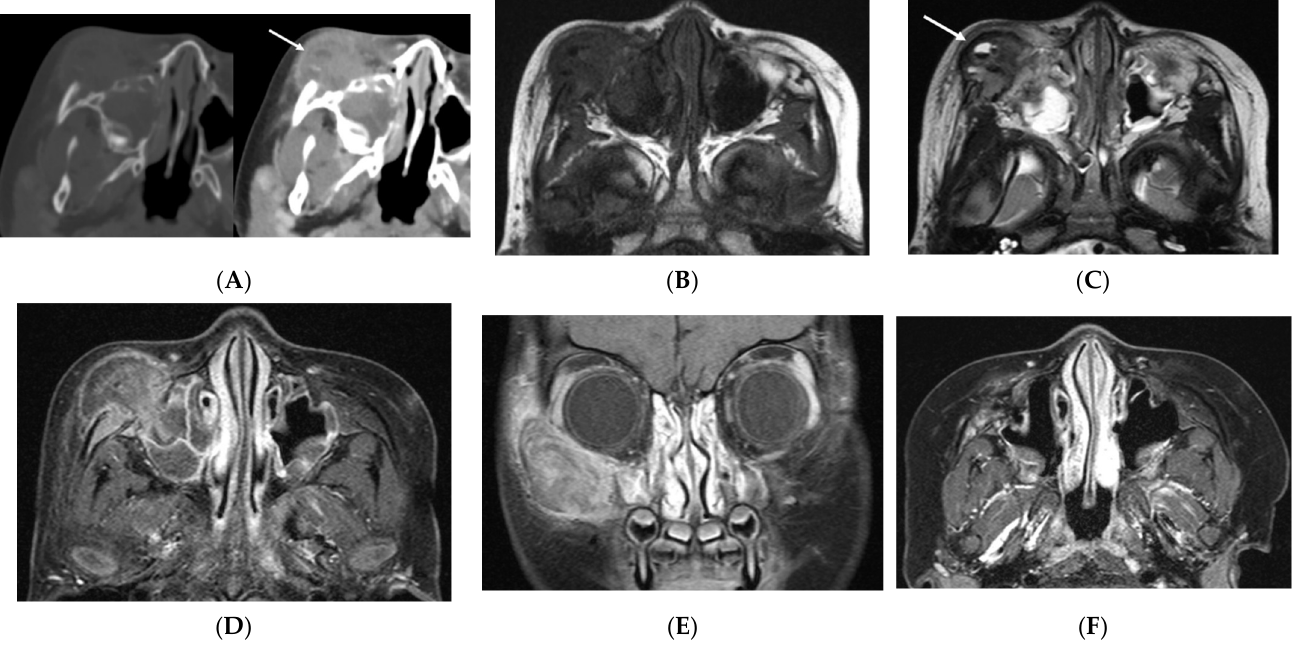
Figure 1. 27-month-old girl with rapidly progressive facial swelling and redness. ( A ) Axial orbital CT bone and soft tissue window images show an expansile osteolytic lesion with associated soft-tissue mass involving the anterior wall of the right maxillary sinus and periorbital area. On axial and coronal MR imaging, the mass shows an ( B ) iso signal intensity (SI) on T1WI and ( C ) mixed high and low SI on T2WI, ( D , E ) with heterogenous enhancement. A small fluid-fluid level in the anterior aspect of the mass is observed (arrow). Direct invasion of the right inferior orbital wall and adjacent extraconal space is also observed. ( F ) On follow-up MR imaging after two months, the size and enhancement of the mass has decreased, and peritumoral infiltration and maxillary sinusitis are also improved. CT, computed tomography; MR, magnetic resonance; T1WI, T1-weighted imaging; T2WI, T2-weighted imaging .